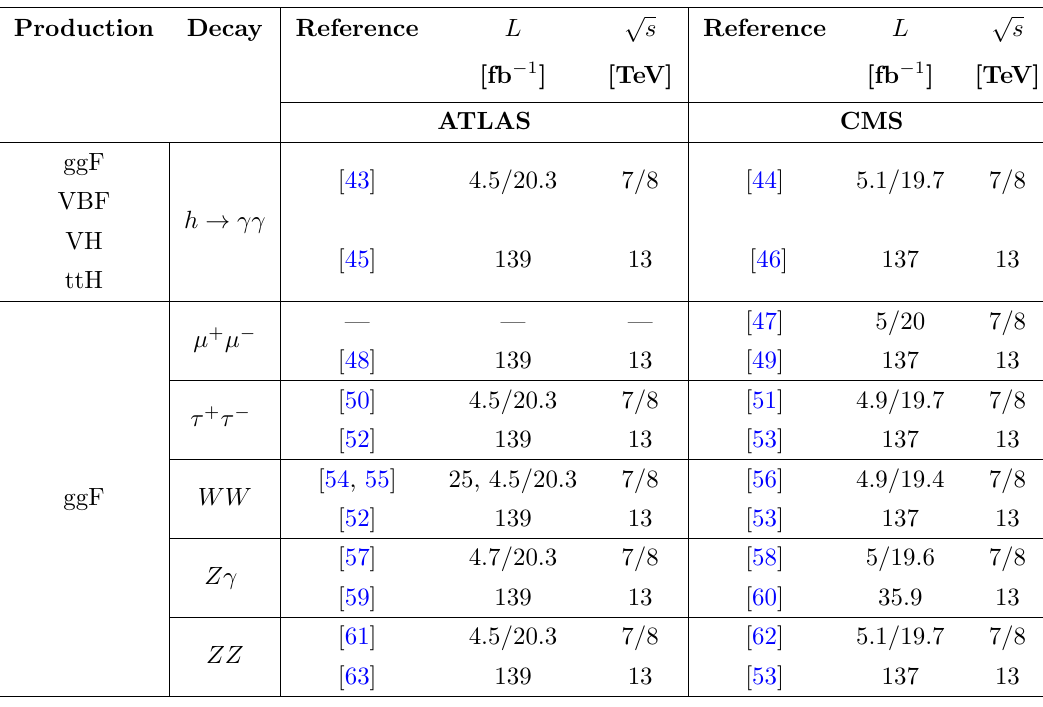
Table 2 . Higgs signal strengths measured by ATLAS and